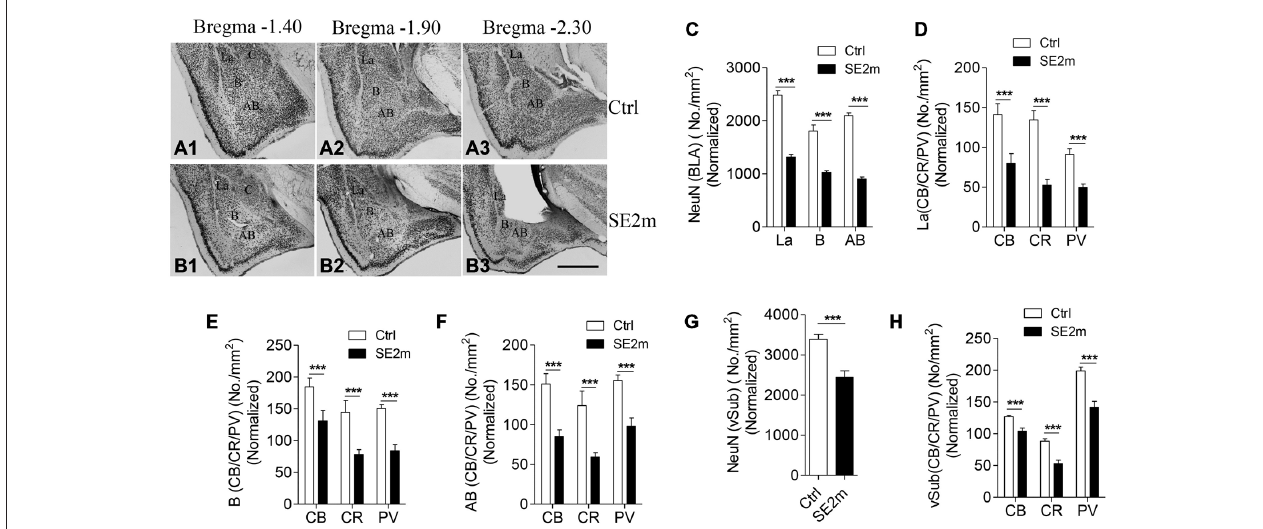
FIGURE 1 | Neuronal loss in the BLA and vSub of epileptic mice induced by pilocarpine treatment. Immunocytochemistry for NeuN shows the lateral (La), basal (B) and accessory basal (AB) nuclei in BLA of control (A1–3) and epileptic mice (B1–3) . Bar graph (C) shows the number of neurons (NeuN positive) per area (mm 2 ) in the different regions (La, B and AB) of the amygdala in epileptic mice (SE2m) normalized to the corresponding areas in control mice (Ctrl; Student’s t -test, ∗∗∗ p < 0.001). Bar graphs (D–F) show the number of CB-, CR- or PV-immunopositive neurons (Student’s t -test, ∗∗∗ p < 0.001) per area (mm 2 ) at the La, B and AB nuclei of amygdala in epileptic and control mice. Bar graph (G) shows the number of NeuN positive neurons per area (mm 2 ) in the vSub of epileptic and control mice (Student’s t -test, ∗∗∗ p < 0.001). Bar graph (H) shows the number of CB-, CR- or PV-immunopositive neurons per area (mm 2 ; Student’s t -test, ∗∗∗ p < 0.001) at the vSub in epileptic and control mice. Scale bar = 200 µ m in (B3) applies to (A1–3) and (B1–2) . The numbers of neurons per area in epileptic mice on all graphs were normalized to the corresponding areas in control mice.